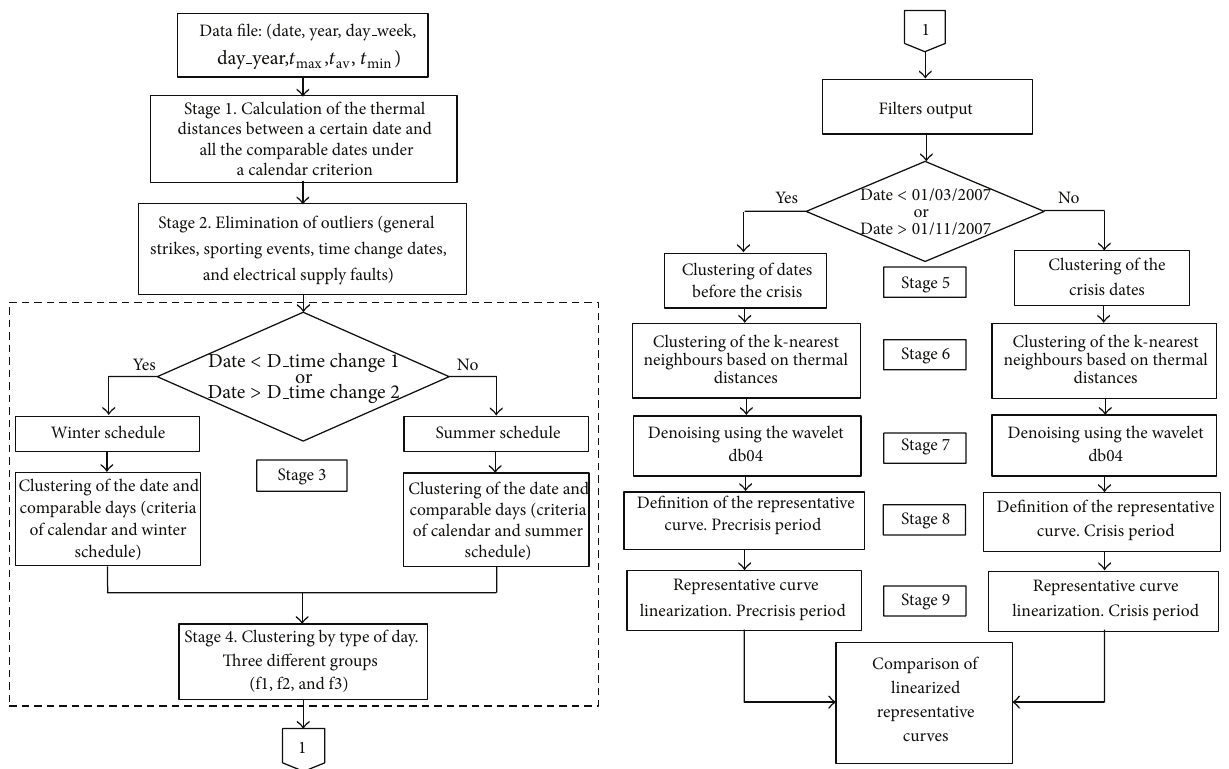
Figure 1: Stages of the proposed